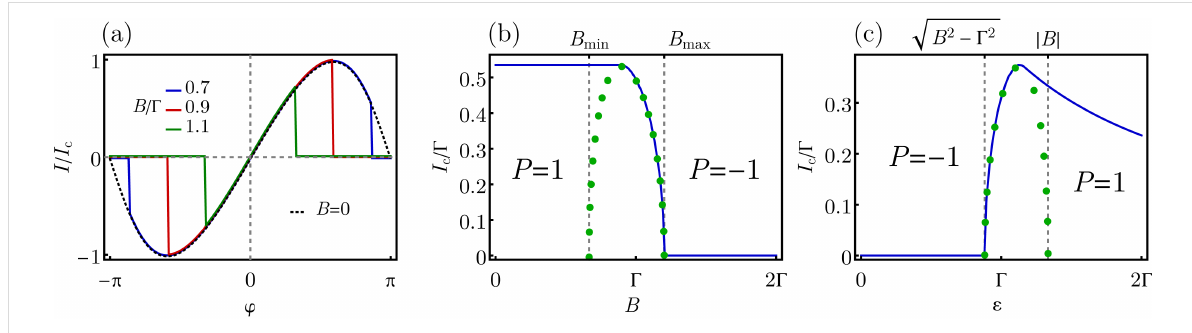
Figure 4: (a) Josephson CPR of the SC–QD–SC junction for different choices of the Zeeman field B in the limit T → 0 (Equation 23) in units of the criti- cal current of the trivial branch. We take ε = 2 Γ /3. Depending on the Zeeman field, different regimes are realized: At small fields | B | < B min (i.e, λ > 1, dotted line) the current is smoothly oscillating as a function of the phase φ and the system is topologically trivial ( P = 1). At large fields | B | > B max (i.e., λ < − 1, not shown) the current vanishes and the system is topologically nontrivial ( P = − 1). At intermediate fields B min < | B | < B max (i.e., | λ | < 1, solid lines), discontinuous drops appear at the transition points between the trivial and nontrivial topological states. Current discontinuities correspond to the variations of the fermion parity and to the presence of zero energy modes. (b) Critical current of the SC–QD–SC junction as a function of the Zeeman field at zero temperature (solid line) with ε = 2 Γ /3. (c) Critical current of the SC–QD–SC junction as a function of the electric gate ε at zero temperature (solid line) with B = 4 Γ /3. In both cases, the critical current drops from a finite value in the trivial state ( P = 1 and λ > 1) to zero in the nontrivial state ( P = − 1 and λ < − 1). In the transition regions B min < B < B max (b) and < | ε | < | B | (c), the trivial and nontrivial states alternate at different phases φ . As one can see, when the system approaches its nontrivial state P = − 1, the critical current coincides with the magnitude of the discontinuous drop Δ I (green dots) given in Equation